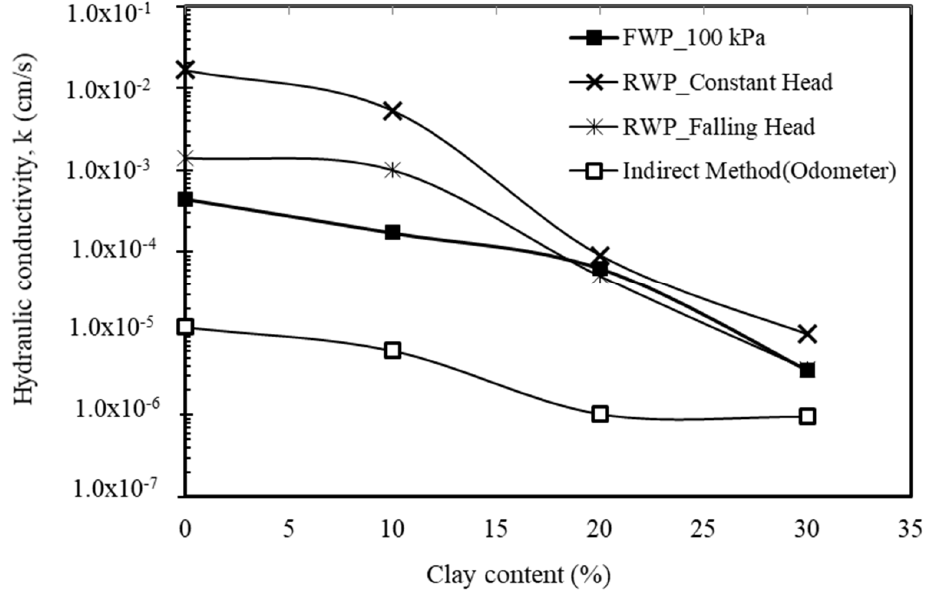
Figure 7. Hydraulic conductivity for a flexible wall at 100 kPa stress compared to other methods.